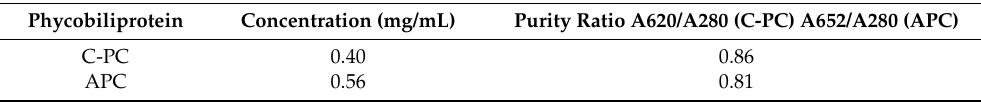
Table 1. Concentration and purity ratio of ExPhy.